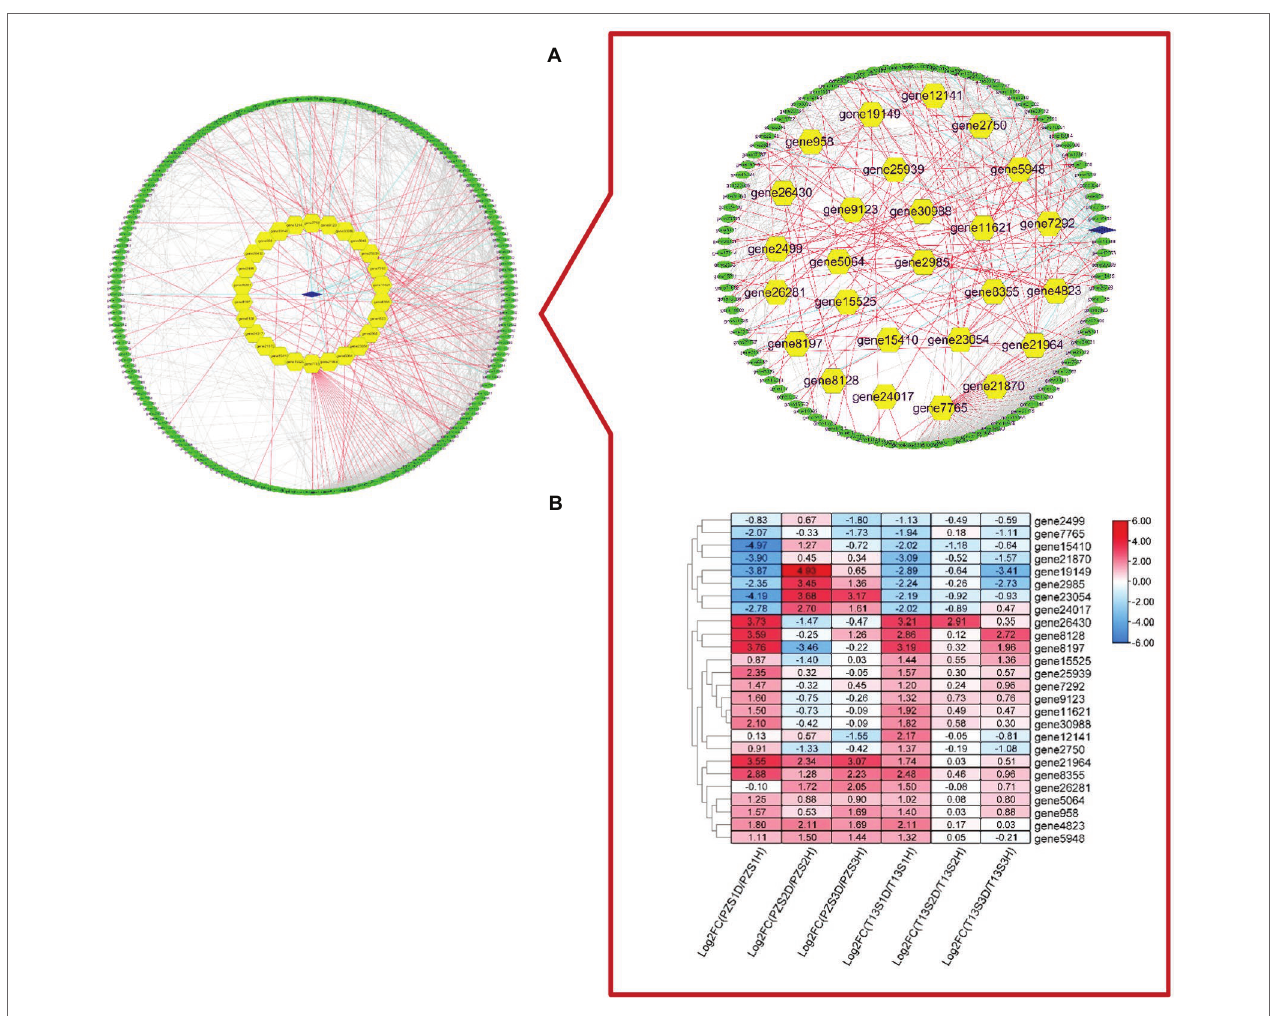
FIGURE 4 | The protein–protein interaction prediction of 418 key DEGs that were mainly involved in hormone and oxidative processes with Gene Ontology (GO) and KEGG enrichment selection. (A) Protein–protein interaction prediction of 235 DEGs. (B) Heatmap of the expression level of the 26 key genes in six pairwise comparisons (T13S1H vs. T13S1D, T13S2H vs. T13S2D, T13S3H vs. T13S3D, PZS1H vs. PZS1D, PZS2H vs. PZS2D, and PZS3H vs. PZS3D) with log 2 Fold calculation. Green ovals represent DEGs expressed in “PZ,” blue diamonds represent DEGs expressed in “T13,” and yellow hexagons represent DEGs expressed in “T13” and